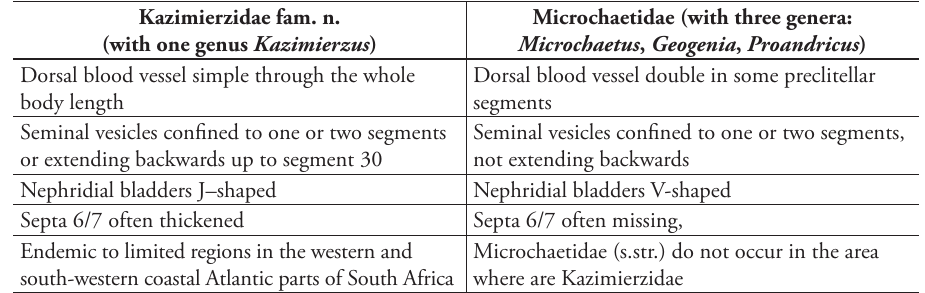
Table 1. Diagnostic characters for Kazimierzidae fam. n. and Microchaetidae. Kazimierzidae fam.